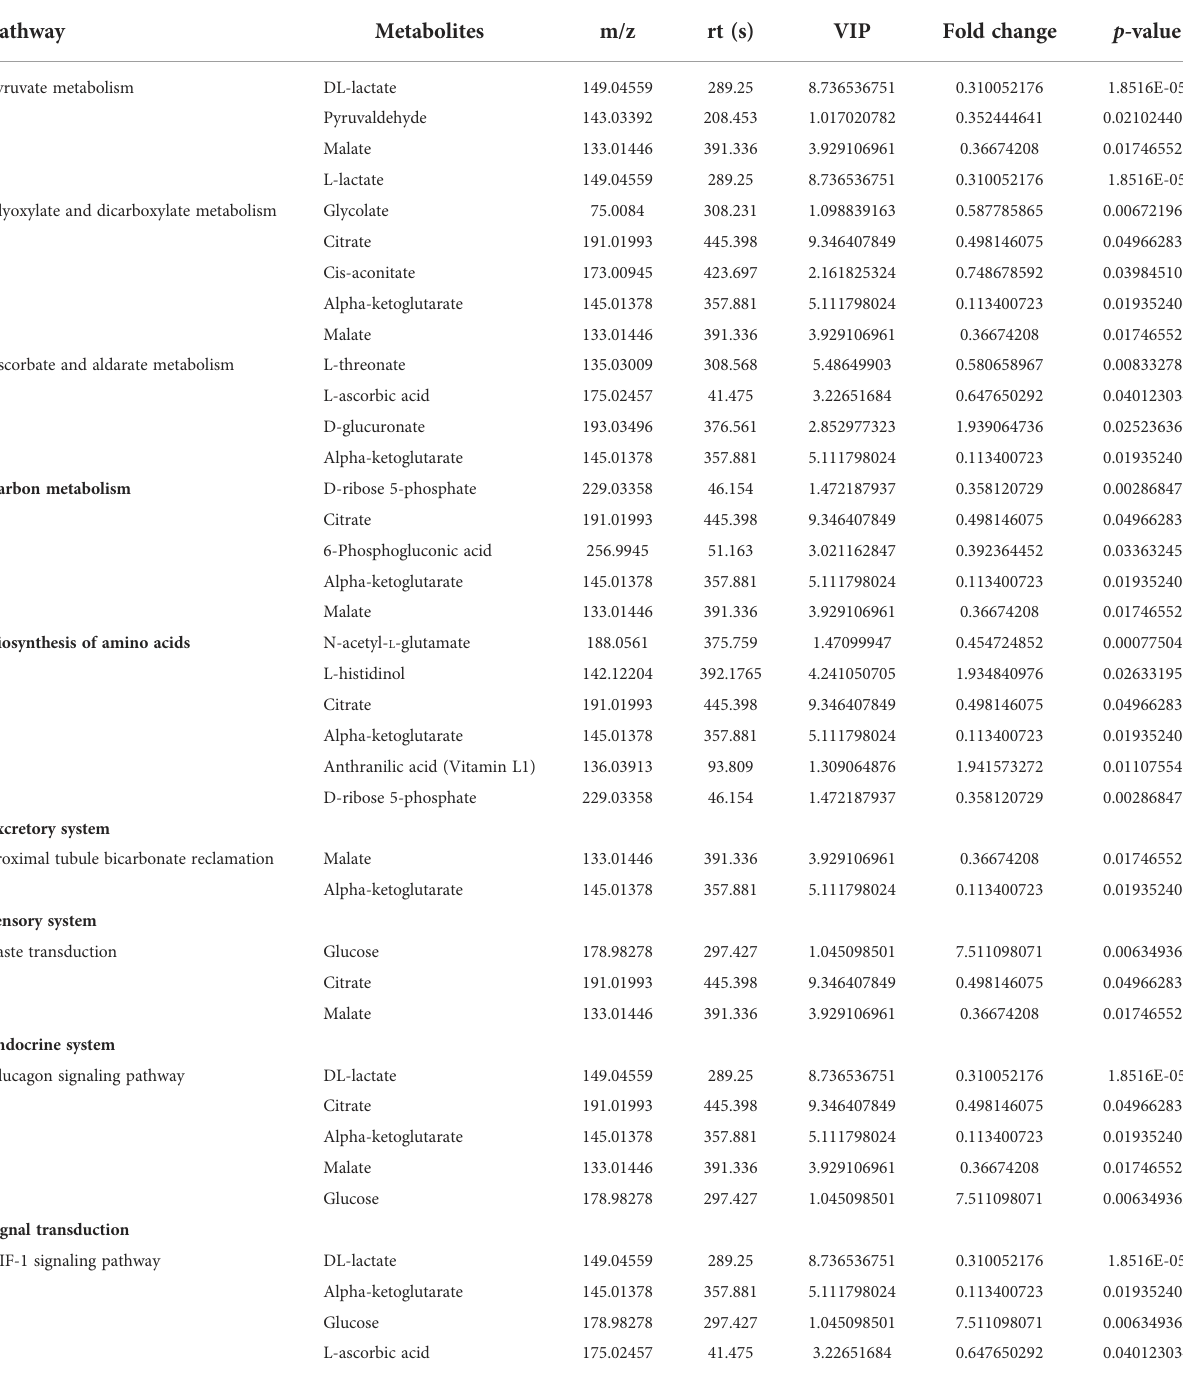
values of the nine representative biomarkers are shown in Figure 6A, and the normalized abundance of the different potential biomarkers is shown in Figure